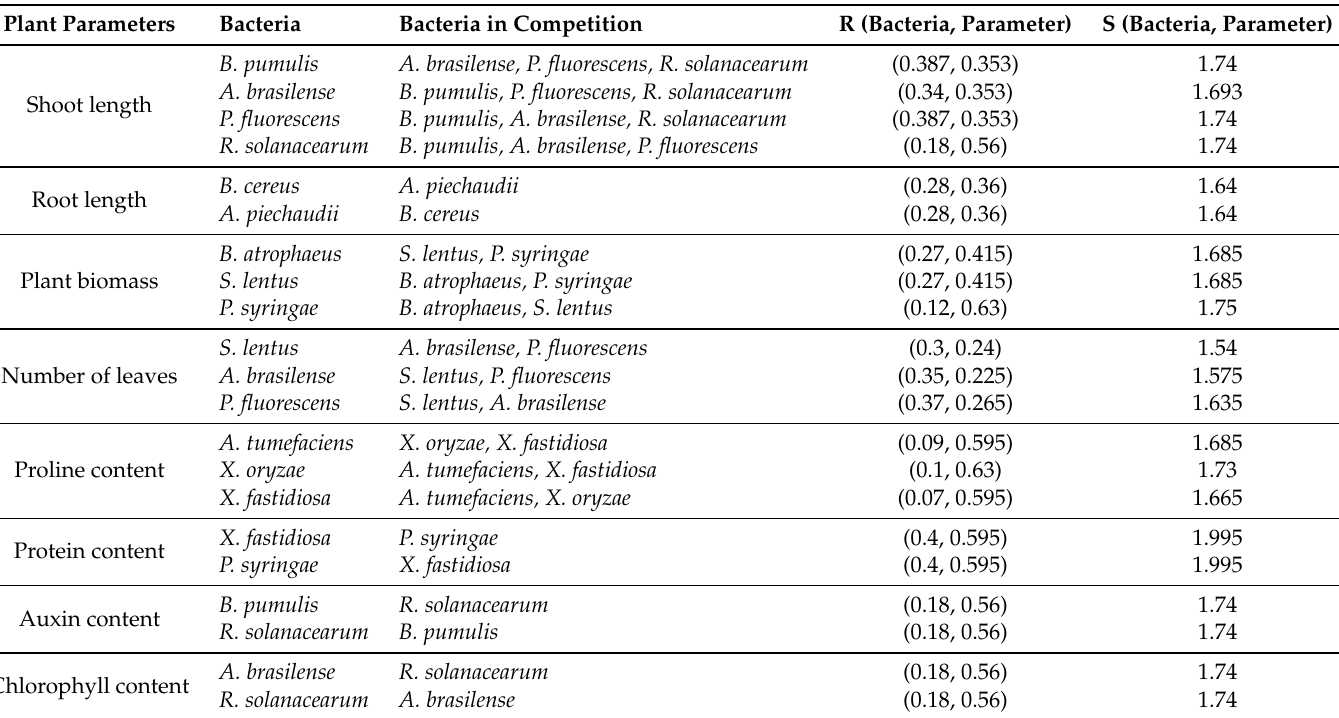
Table 4. Strength of competition of bacteria for plant